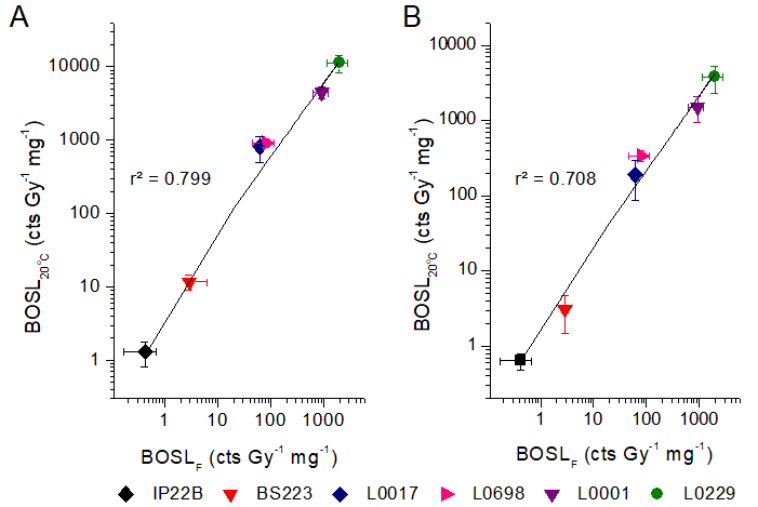
Table 7. Comparison between BOSL F sensitivity [30] and sensitivity measured at room temperature (BOSL 20°C ) for silt aliquots from GeoB16206-1 sediment core. Sensitivity values correspond to the average of three aliquots (± standard deviation). Data normalization included subtraction of mean and division by the standard deviation of the data set (%BOSL 20°C or %BOSL F ).